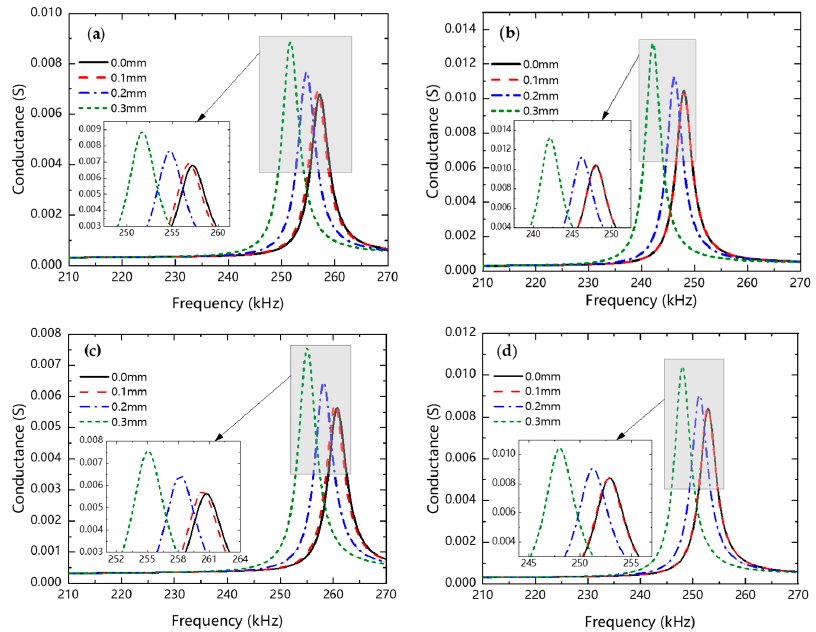
Figure 10. Numerical conductance signatures of the ( a ) 0 ° flat, ( b ) 90 ° flat, ( c ) 0 ° rough , and ( d ) 90 ° rough PZT sensors embedded in concrete cubes under inelastic deformation.